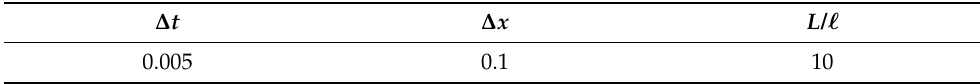
Table A1. Numerical values for one-dimensional